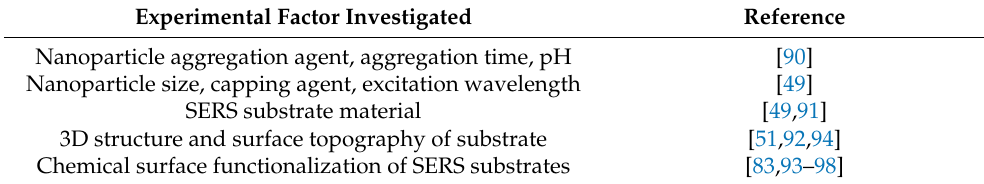
Table 1. Summary of experimental factors, studied in terms of their influence on the performance of SERS